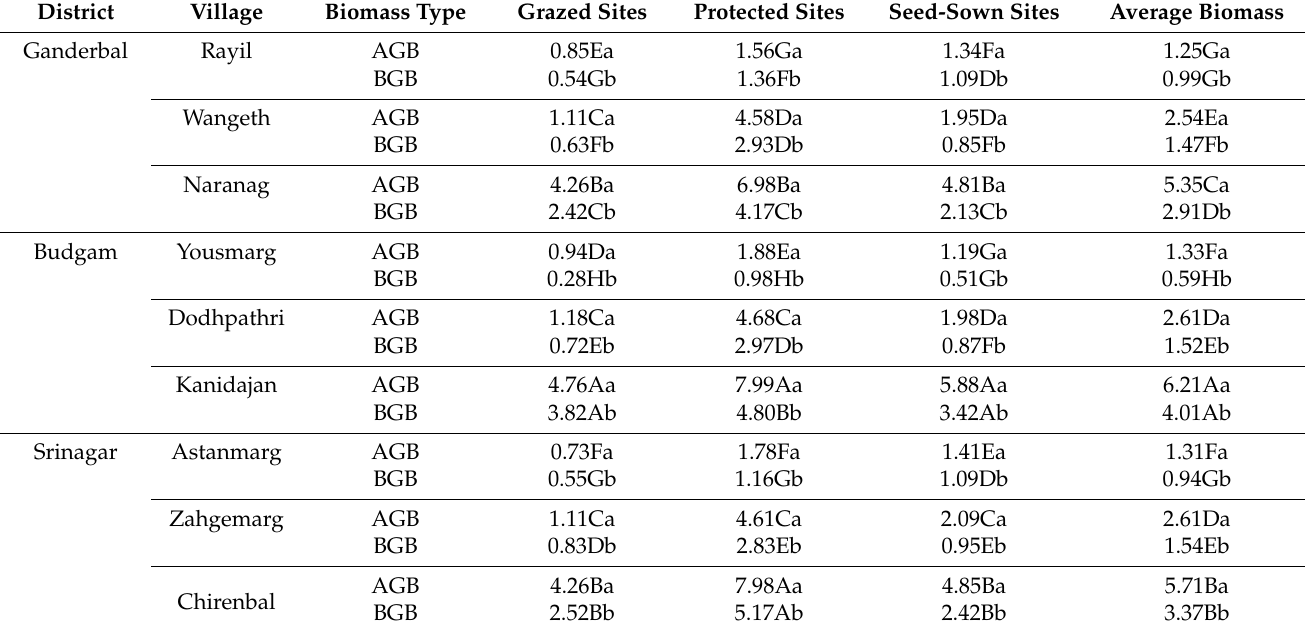
Duncan test; means within the same column (comparison between AGB and BGB within each village) followed by different lowercase letters are significantly different at p < 0.05 according to the Student’s t-test.